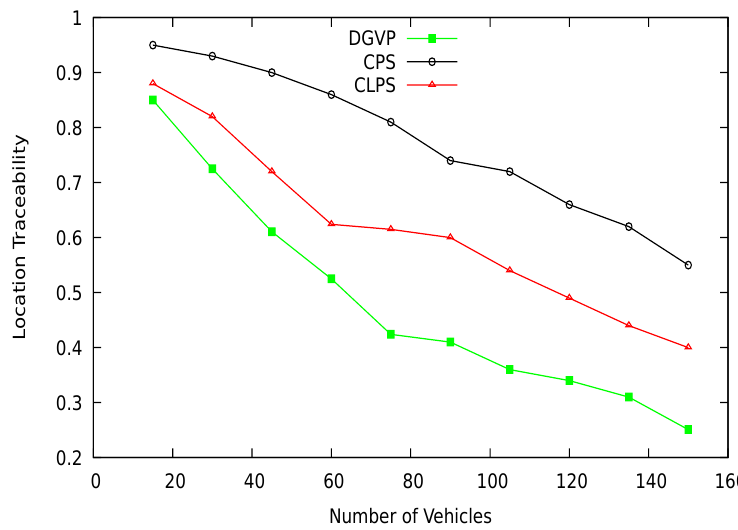
Figure 20. Location traceability at different vehicle traffic conditions.